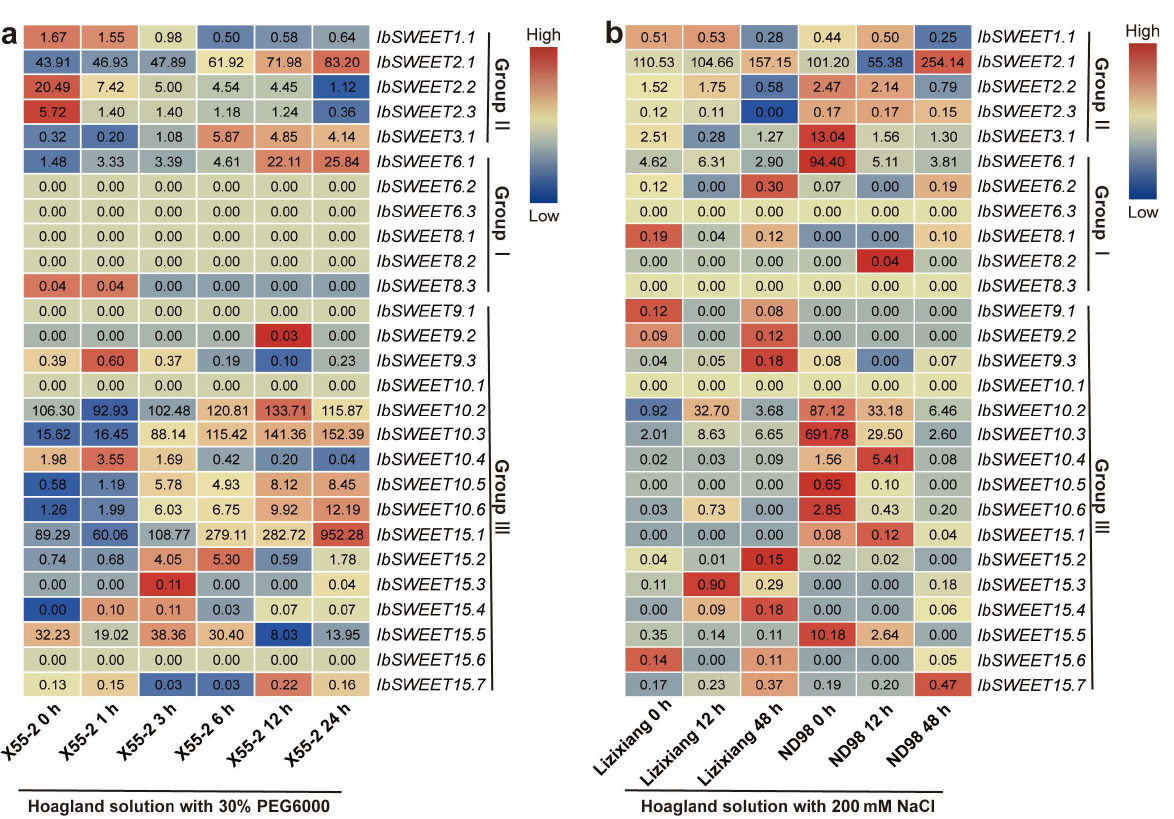
Figure 12. Gene expression patterns of IbSWEETs under drought and salt stresses as determined by RNA-seq. ( a ) Expression analysis of IbSWEETs under PEG treatment in a drought-tolerant variety, i.e., Xu55-2. ( b ) Expression analysis of IbSWEETs under NaCl treatment in a salt-sensitive variety, i.e., Lizixiang, and a salt-tolerant line, i.e., ND98. The log 2 (FPKM) value is shown in the boxes.